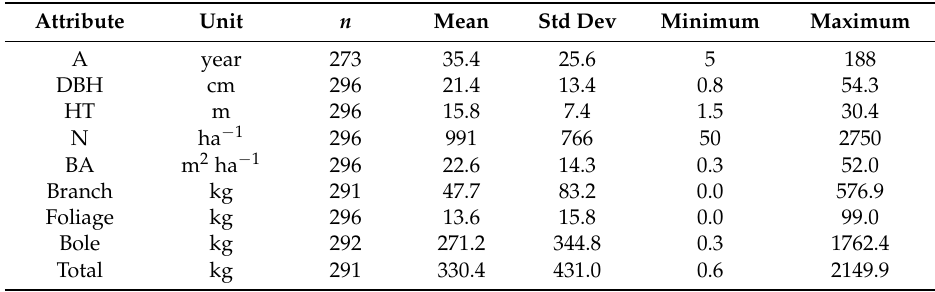
Table 2. Summary statistics of tree and their associated stand characteristics for the sampled longleaf pine trees.